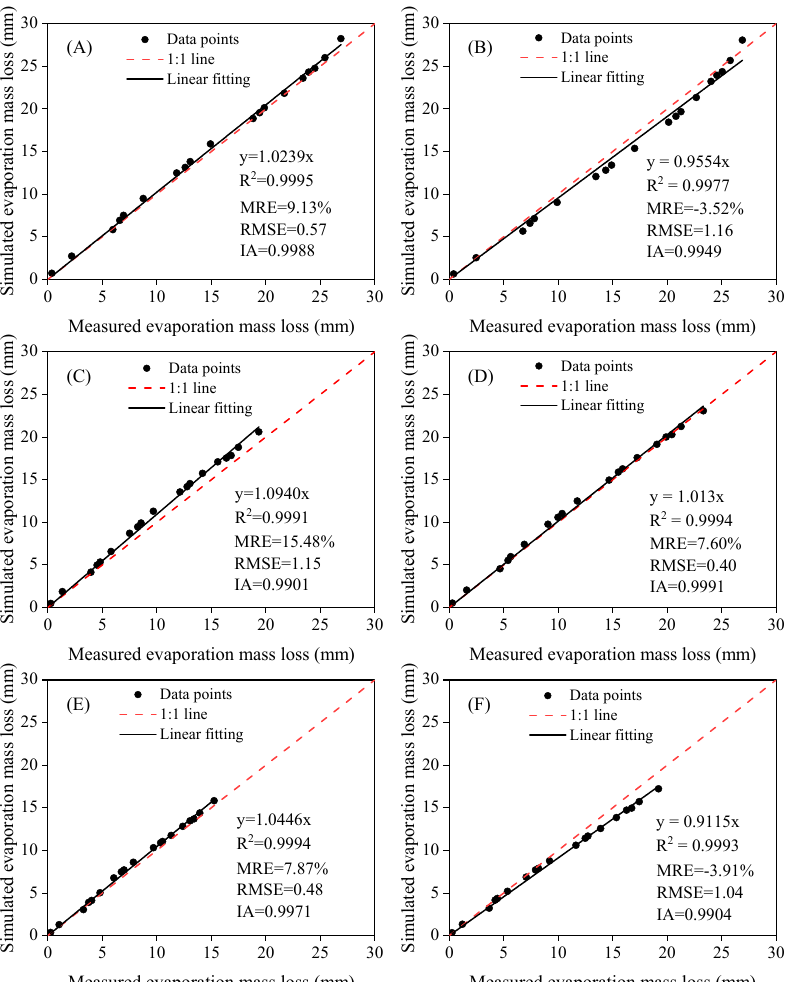
Figure 10. Relationship between simulated and measured evaporation mass losses for the six treat- ments: ( A ) T1-calibration; ( B ) T2-validation; ( C ) B1-calibration; ( D ) B2-validation; ( E ) G1-calibration; ( F ) G2-validation.